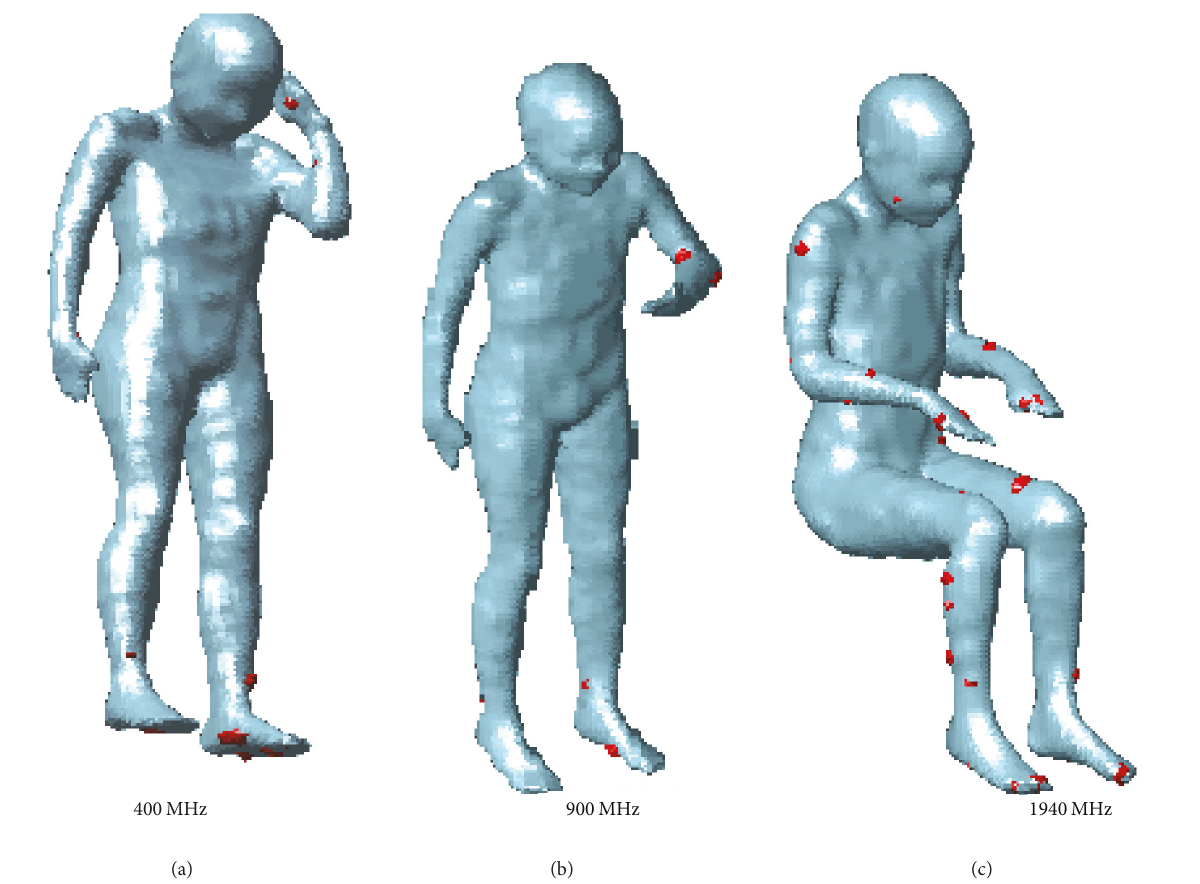
Figure 15: Identification of SA 𝑅 peak 10 peak locations. (a) Voice-standing-900 MHz , (b) voice-sitting-900 MHz, and (c) data-sitting-1940 MHz . g